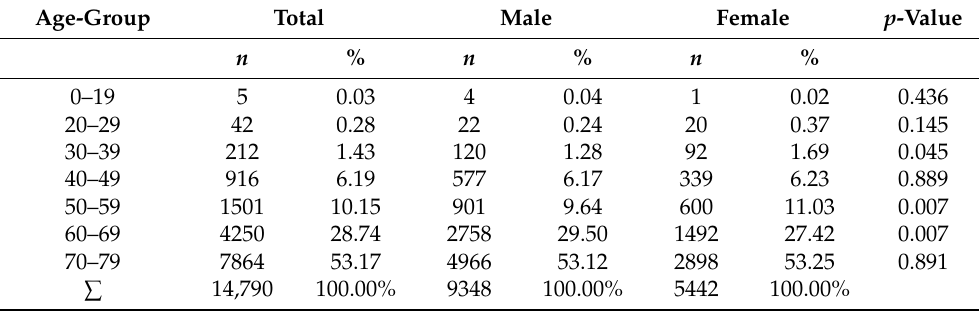
Table 4. Distribution of stomach cancer mortality by gender and by age groups. Age-Group Total Male Female p -Value